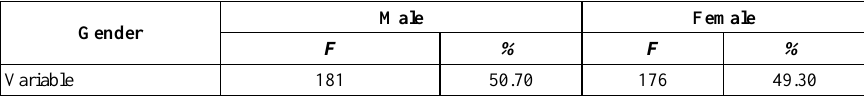
Table 1. Distribution of university students by gender variable